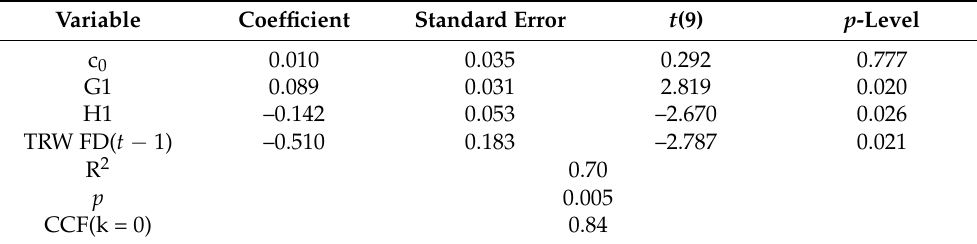
Table 5. Parameters of model (2) based on the data averaged over the sample plots.